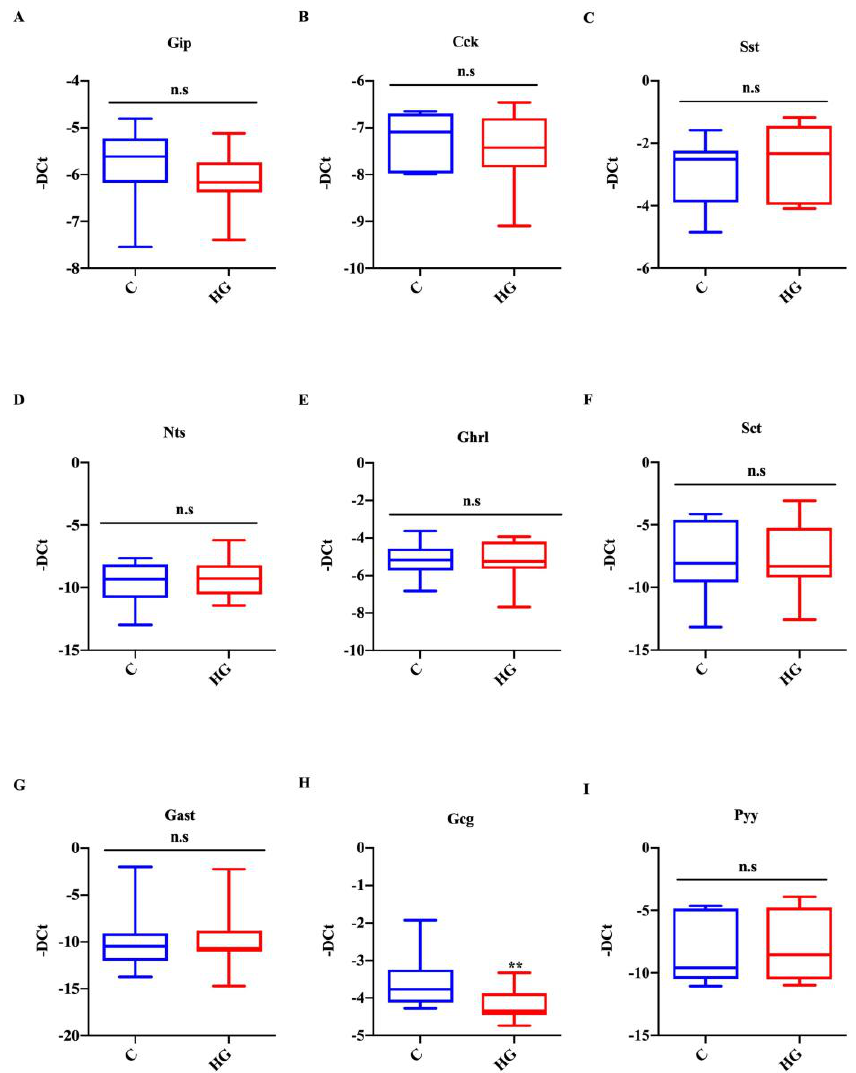
Figure 5. Action of high glucose treatment on EEC markers. Expression of Gip ( A ), Cck ( B ), Sst ( C ), Nts ( D ), Ghrl ( E ), Sct ( F ), Gast ( G ), Gcg ( H ), and Pyy ( I ) in intestinal organoids exposed to high glucose (35 mM) for 48 h. Data generated from three biological replicates from five mice. Unpaired Student t -test: ** p < 0.01; n.s. not significant. C = Control (17.5 mM glucose). HG = High Glucose (35 mM glucose).